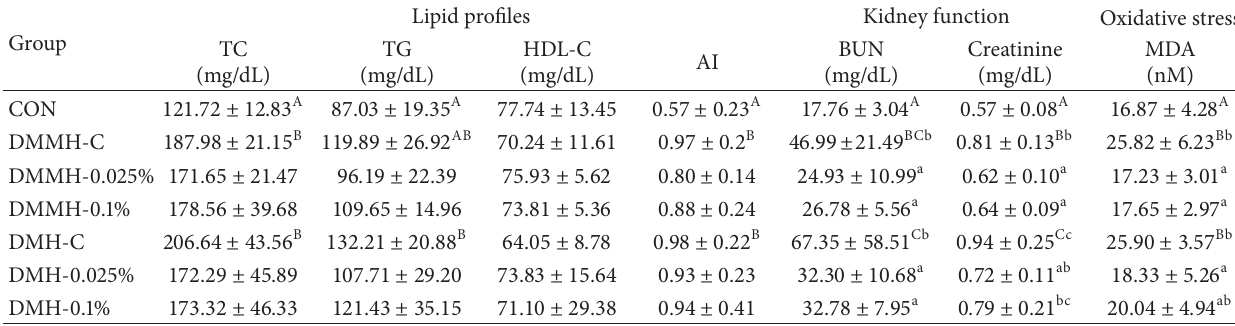
Figure 2: Effect of genistein supplementation on fasting blood glucose levels in experimental mice. Fasting blood glucose levels in DMMH group (a) and fasting blood glucose levels in DMH group (b). Data are presented as means ± SD ( 𝑛 = 9 -10/group). Mean values with different letters were significantly different, 𝑃 < 0.05 . Statistical differences of variables between CON and DMH-C analyzed by unpaired t -test were shown in capital letters and effects of the genistein supplemented diets on body weight and food intake in diabetic mice using one-way ANOVA was represented by small letters. Table 2: Effect of genistein supplementation on biochemical